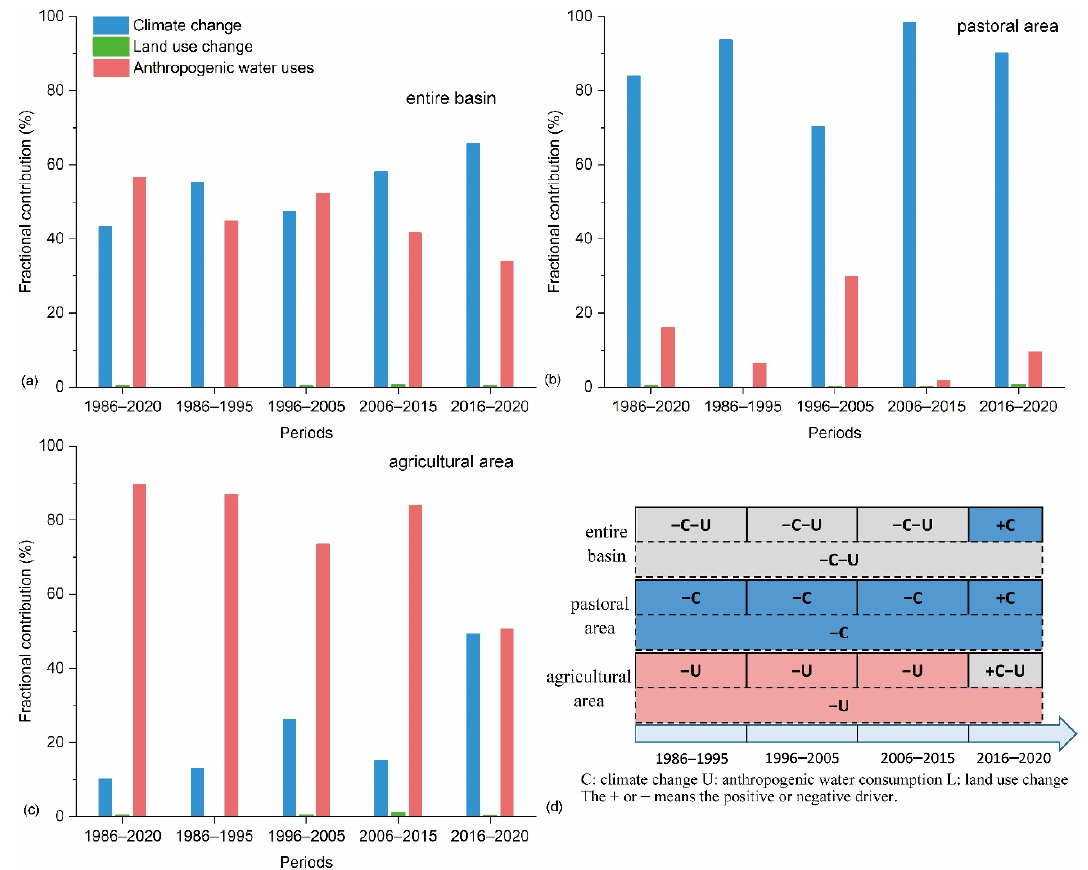
Figure 6. Relative contributions of climate change, land-use change and anthropogenic water uses to runoff changes in the upper Yellow River Basin from 1986 to 2020. The contributions are for ( a ) the entire UYRB, ( b ) pastoral area and ( c ) agricultural area, respectively. ( d ) Spatiotemporal variations of dominant drivers in this basin over the past 35 years.